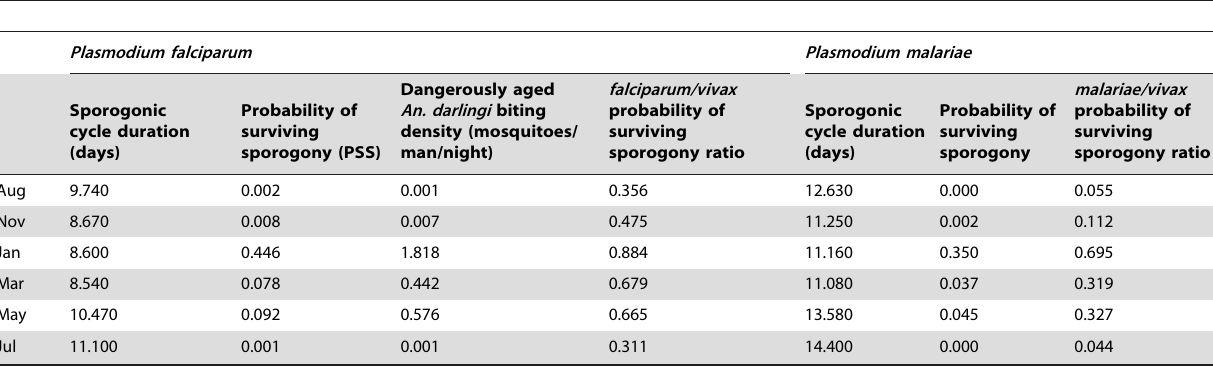
Table 5. Sporogonic cycle durations for Plasmodium falciparum and P. malariae , probability of surviving sporogony, density of dangerously aged Anopheles darlingi and probability of surviving sporogony ratios between these species and P. vivax